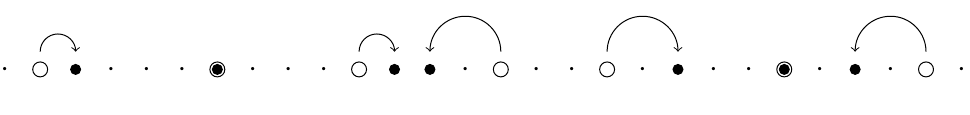
Figure 9: Sketch of the states contributing to the leading asymptotics: position of the momenta of the representative state (empty circles), position of the momenta of the intermediate state (filled circles), and position of the holes